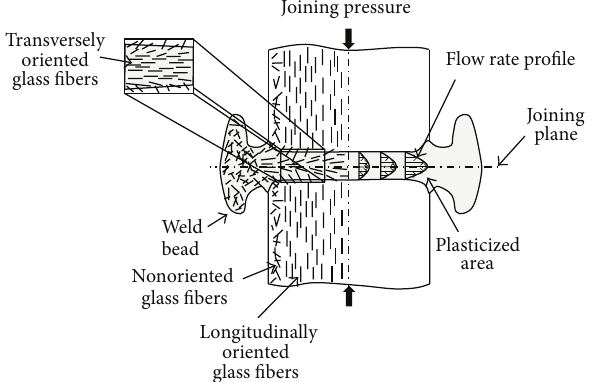
Figure 1: Schematic representation of the reorientation of fibers in the weld due to squeeze flow [4].